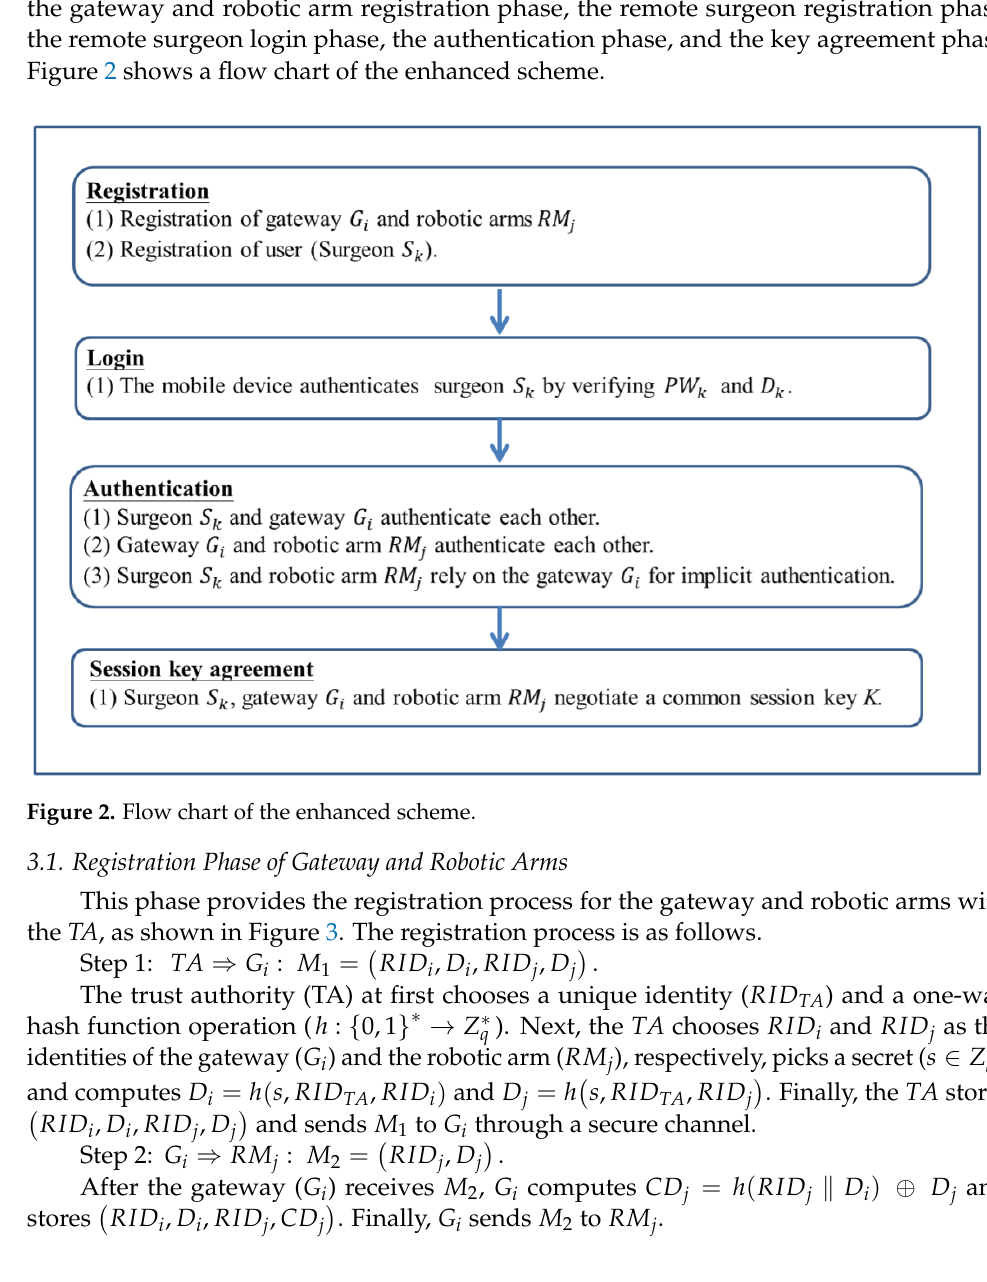
Figure 3. Registration process of gateway and robotic arms of the enhanced scheme.